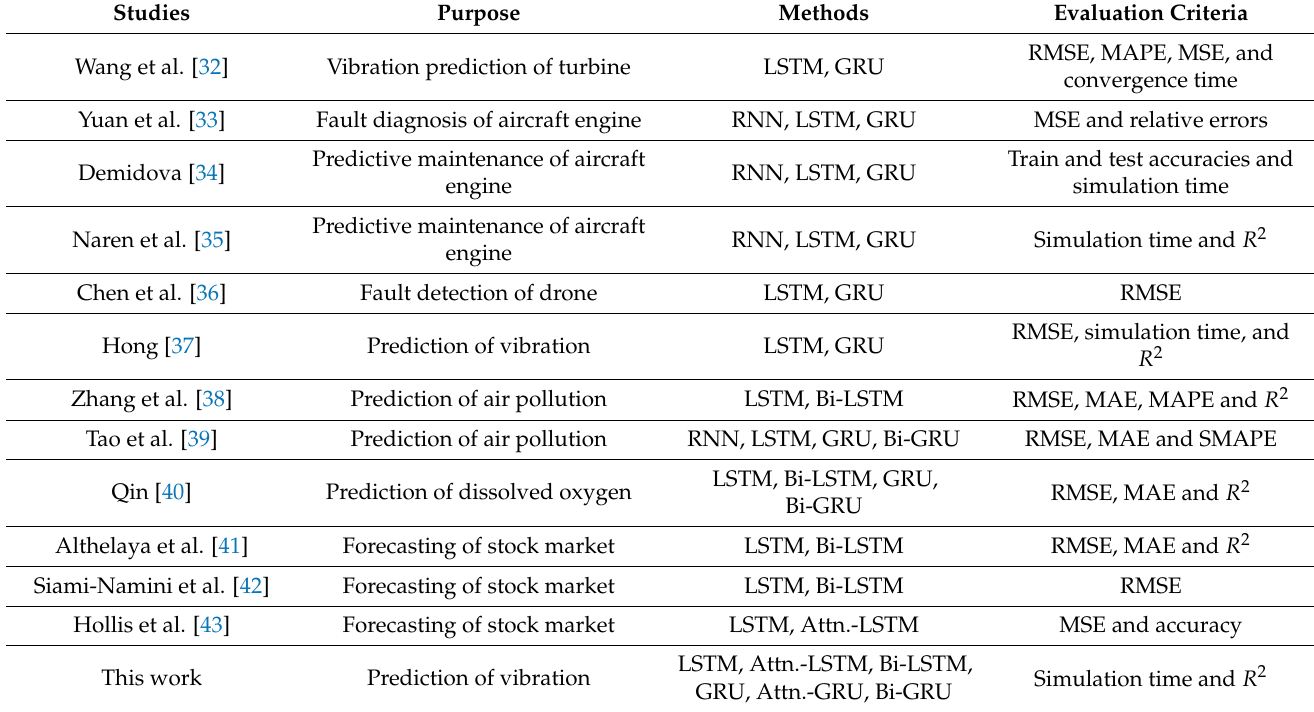
Table 1. The literature using more than two RNN